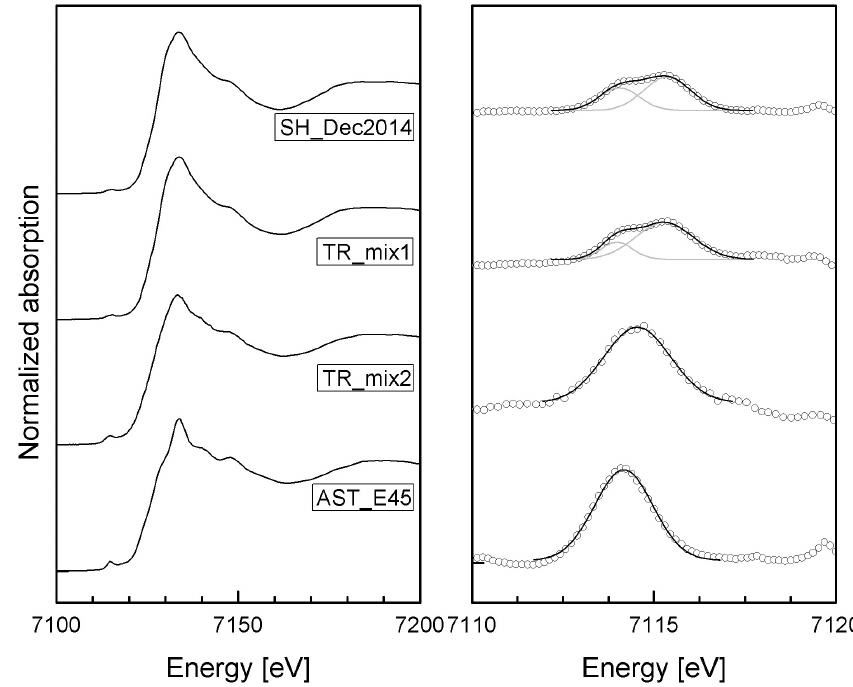
Figure 1. ( Lefthand panel ) XANES spectra of the Saharan dust (SH_Dec2014), steel production fumes (AST_E45) and mixed aerosol samples collected in the Terni urban area (TR_mix1 and TR_mix2). ( Righthand panel ) Blow-up of the pre-edge features of the same samples is shown in the lefthand panel. Here the open circles are the experimental points and the lines the model best fits (see